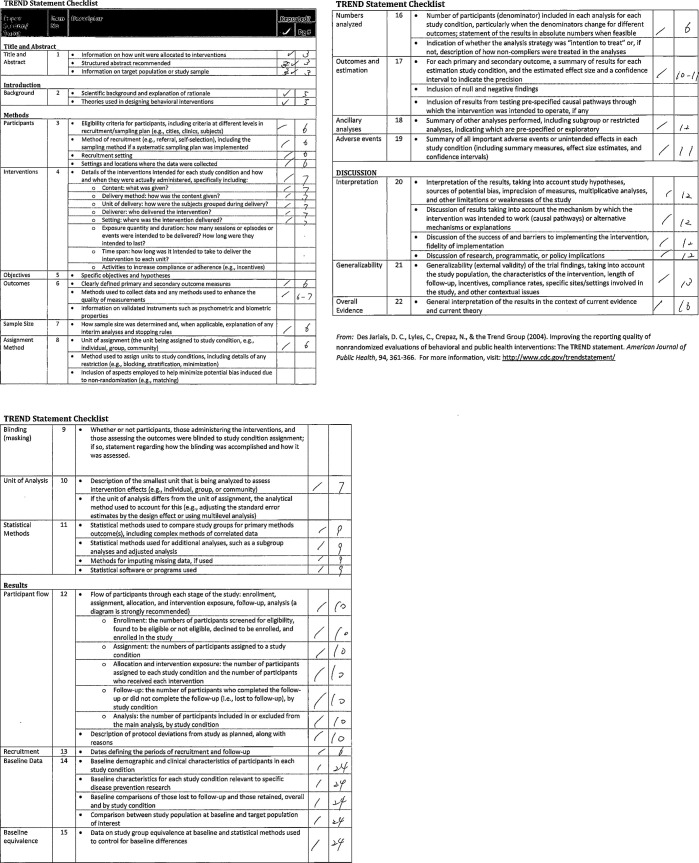
TREND checklist.We checked 22 points including TREND statement checklist. All points were included in our study.